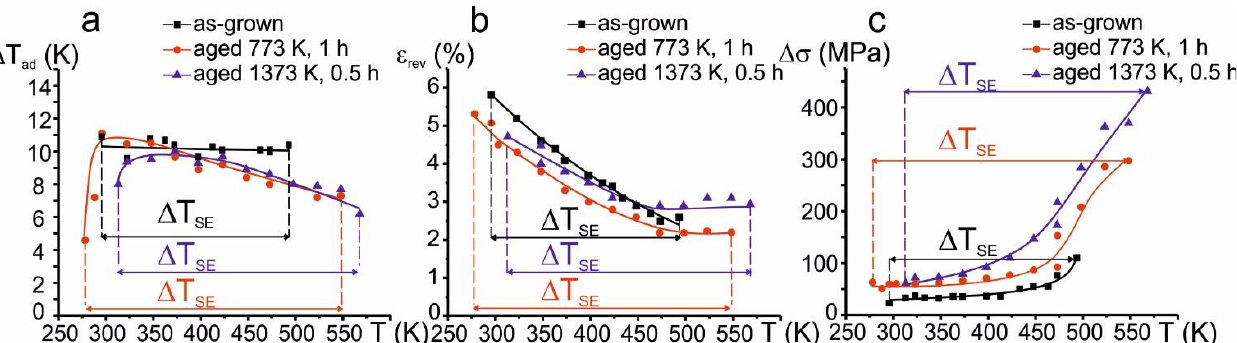
Figure 6. Temperature dependence of the adiabatic temperature change ΔT ad ( a ), transformation reversible strain ε rev ( b ), and stress hysteresis Δσ ( c ) in loading/unloading cycles in [001]-oriented as-grown and aged Ni 54 Fe 19 Ga 27 single crystals.